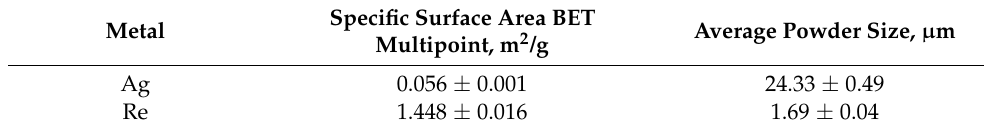
Table 1. Properties of powders used for manufacturing contact materials.